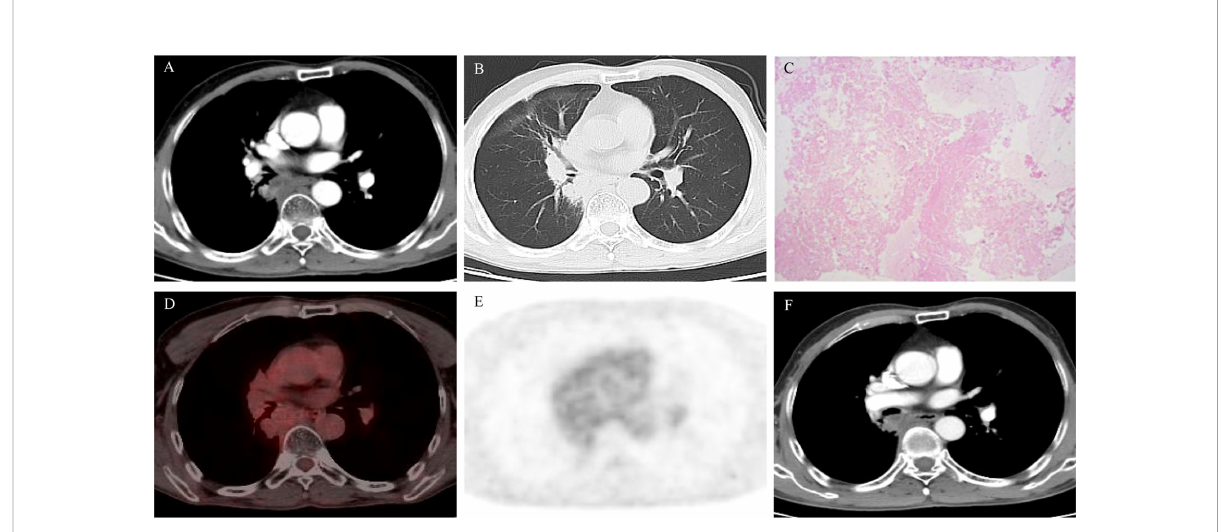
FIGURE 3 (A, B) Computed tomography (CT) scan after 11.5 months of osimertinib therapy showed enlarged primary mass; (C) hematoxylin and eosin (H&E) stain of the mediastinal biopsy tissue sample demonstrating extensive necrosis without tumor cells; (D, E) PET/CT scan after 11.5 months of osimertinib therapy showed no fl uorodeoxyglucose avidity; (F) CT scan after 18.5 months of osimertinib treatment showed no relapse or